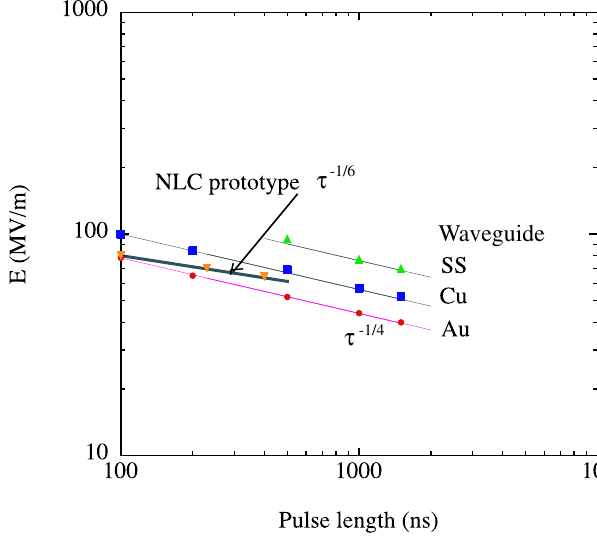
FIG. 11. (Color) Comparing pulse length estimates with data from NLC prototype cavities and SLAC waveguide tests from Refs. [33,35]. The lines show the (cid:6) (cid:11) 1 = 4 – (cid:6) (cid:11) 1 = 6 slopes compatible with the